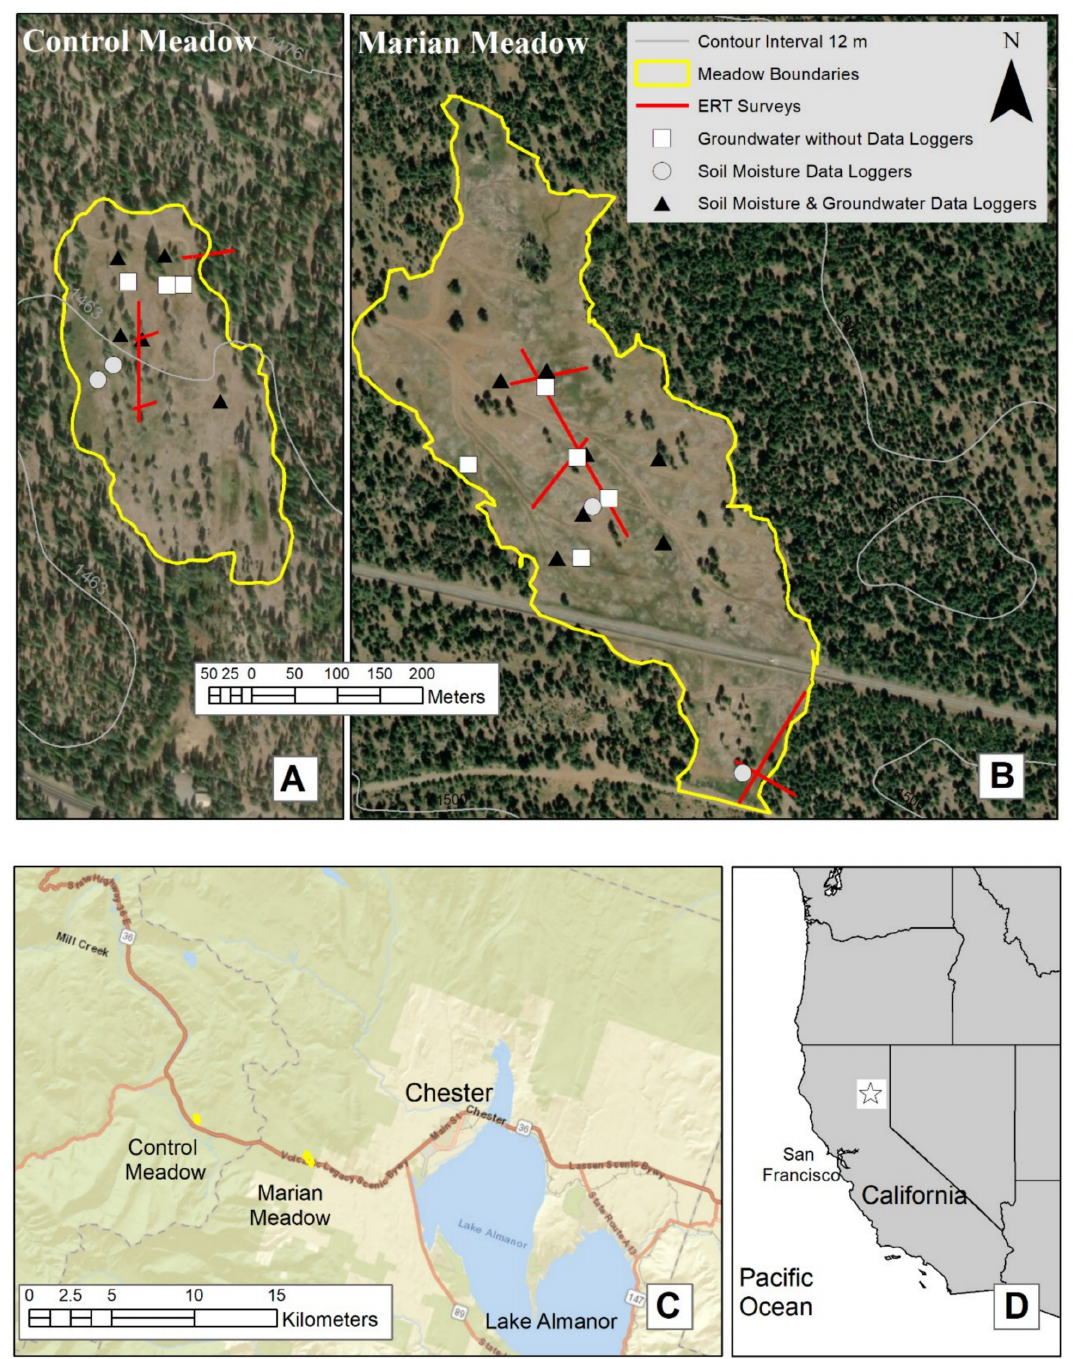
Figure 1. Marian Meadow and Control Meadow study areas. Locations of soil moisture, groundwater depth, and electrical resistivity tomography (ERT) measurements shown. ( A ) Control Meadow. ( B ) Marian Meadow. ( C ) Meadows in relation to city of Chester and Lake Almanor; California State Route 36 is adjacent to both meadows. ( D ) Study sites in relation to California, USA. Satellite imagery and base maps from Earth System Research Institute